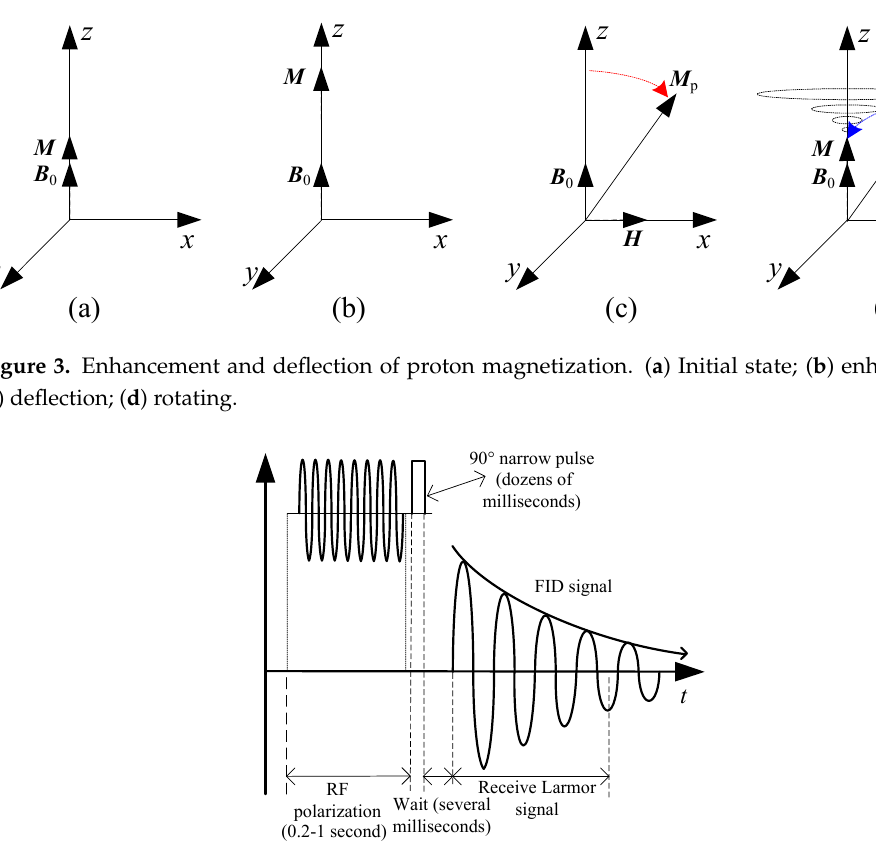
Figure 4. Workflow of the Overhauser